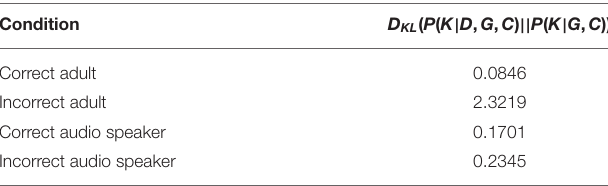
TABLE 1 | KL divergence of K with D compared to without for each type of observation.